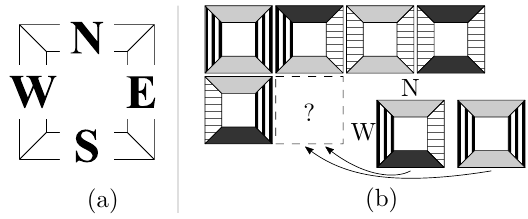
Figure 3. Planar domain tiling, a) edge labels, b) North–Western corner position with two candidate tiles.